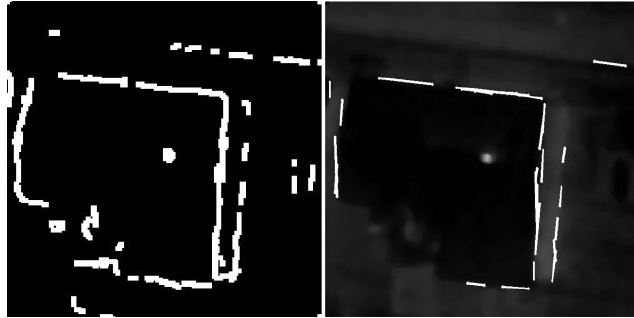
Fig. 4. Image to the left: edges extracted by Sobel edge detector (edges are thickened for illustration purposes). Image to the right: 15 longest lines obtained by Hough transform are shown by white lines. Line Scanning